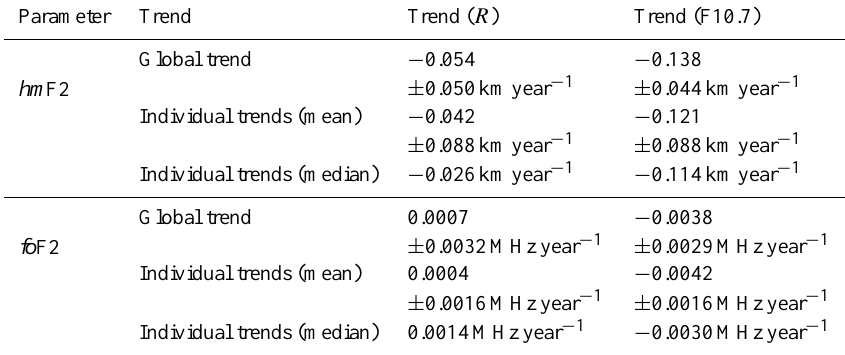
Table 1. Estimated mean trend values of hm F2 and fo F2 with error bars using two different solar activity indices in the trend analyses of 113 stations with hm F2 and 124 stations with fo F2 data for the time interval from 1948 until